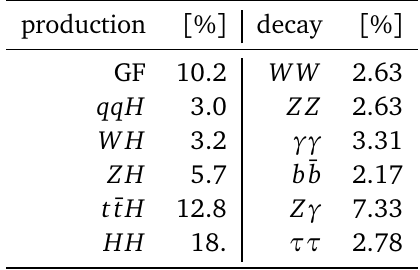
Table 1: Relative theory uncertainties for the different production and decay channels contributing to the global analysis. The numbers correspond to those quoted in